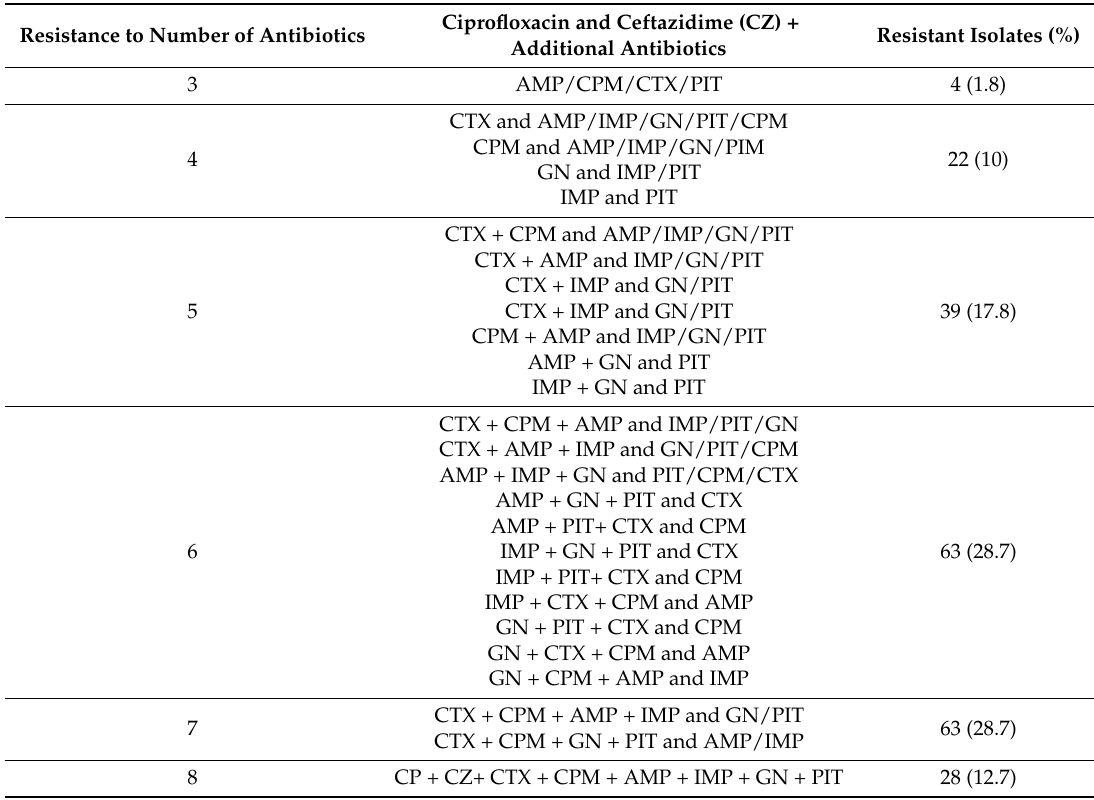
Table 3. Extended antibiotic resistance profile of DDR E.